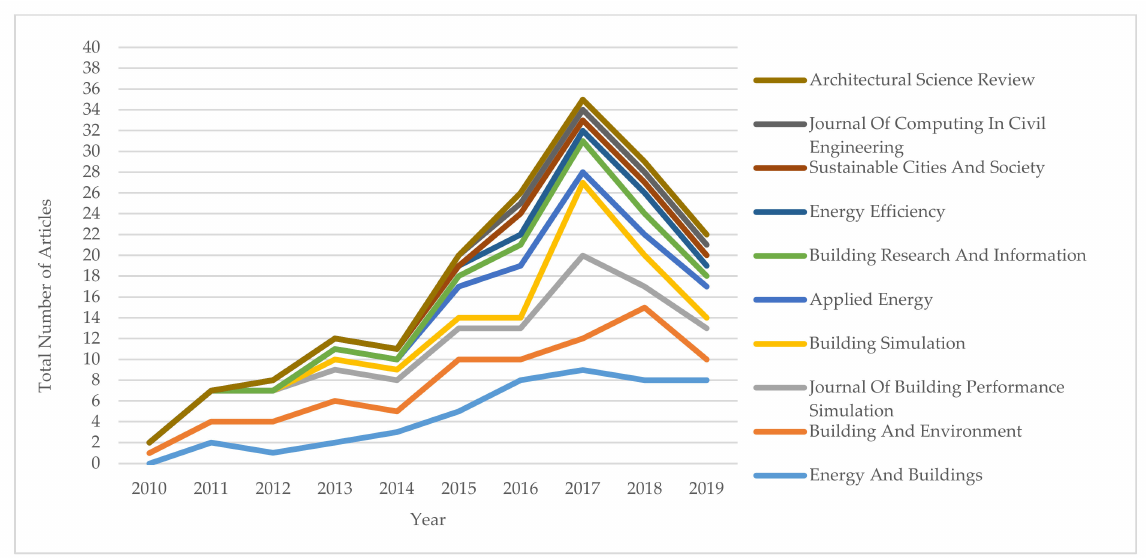
Figure 3. The trend in keywords “Occupant Behavior” and